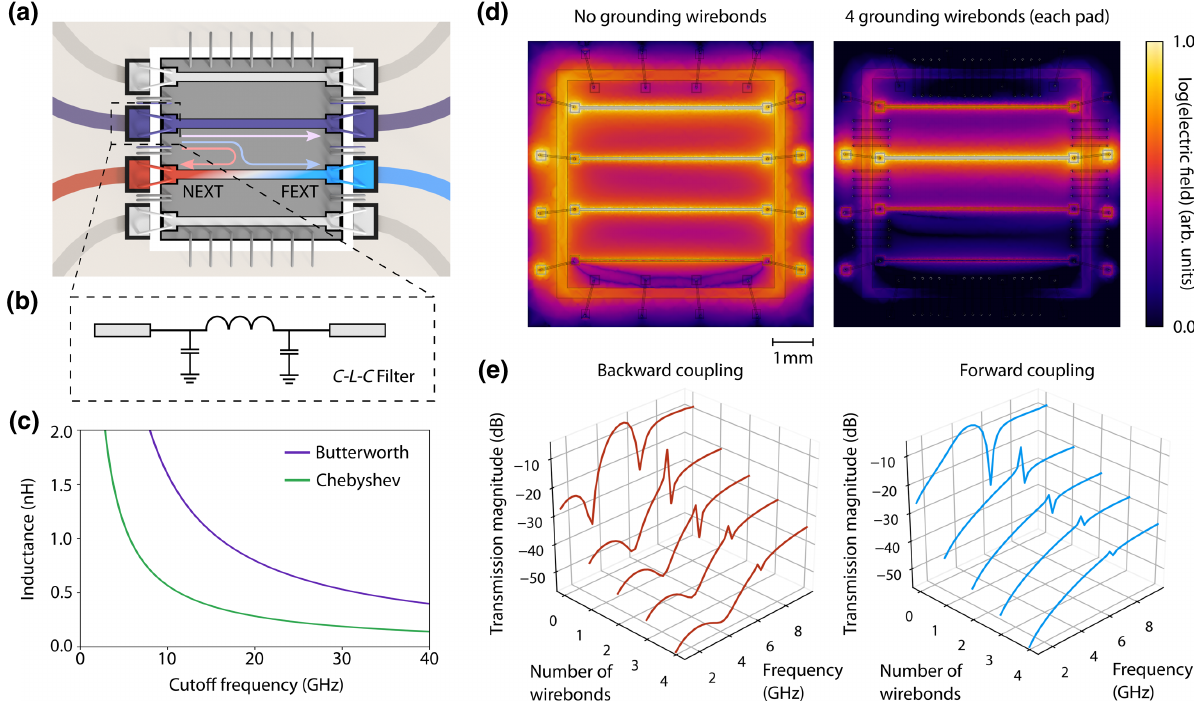
FIG. 3. Wirebond design. (a) Diagram of a chip (gray) with four transmission lines wirebonded to an interposer (beige) surrounding it. The instigating line, indicated in purple, can lead to near-end crosstalk (NEXT) and far-end crosstalk (FEXT) in the disturbed line, shaded red and blue, respectively. (b) Schematic representation of a wirebond interconnect and its lumped element model. The flares located on the ends of the interposer and chip’s transmission lines, as highlighted by the dashed box in (a), correspond to the two tuning capacitors to ground, while the wirebond forms the series inductance. Note that the wirebonds used to connect the signal lines are spread out in a V shape to minimize mutual inductance. (c) Plot of maximum inductance compensation versus cutoff frequency for Butterworth and Chebyshev filter designs, with 1 nH roughly corresponding to 1 mm in wirebond length. (d),(e) The effect of wirebond configuration on signal crosstalk. A simplified model with the same spatial dimensions as the 24-pin design is employed to simulate the relative reduction of signal wirebond crosstalk with the addition of more grounding wirebonds. As the number of grounding wirebonds increases, the electric field strength between the chip ground and the package cavity rapidly decreases, resulting in the suppressed coupling between adjacent signal